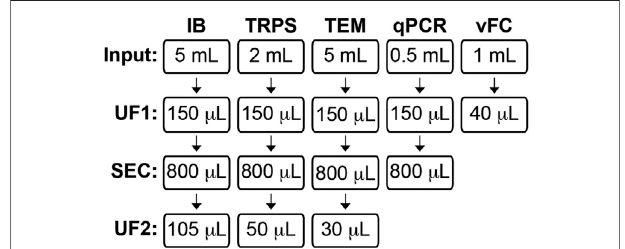
FIGURE1| Human CSFEV studywork fl ow. Human CSFwasassessed using fi ve independent methods: immunoblot (IB), tunable resistive pulse sensing (TRPS), transmission electron microscopy (TEM), qPCR for miRNA analysis, and vesicle fl ow cytometry (vFC). The CSF volume input and subsequent processing step(s) prior to assaying are shown for each technique. CSF for IB, TRPS, and TEM was processed by ultra fi ltration (UF1), followed by size exclusion chromatography (SEC) to collect an 800 µL pool of fractions (Fxs) 6 – 9, and post-SEC UF (UF2) to concentrate the pool. CSF for miRNA qPCR was processed by UF1 and then SEC, and RNA was isolated from an 800 µL pool of Fxs 6 – 9. CSF for vFC was processed by UF-only to concentrate the bio fl uid prior to being assayed.